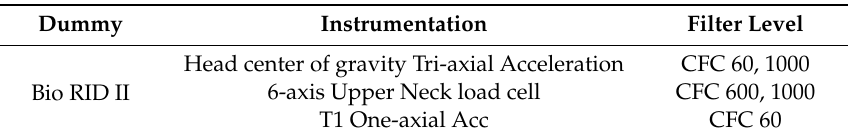
Table 1. Measurement sensors for the